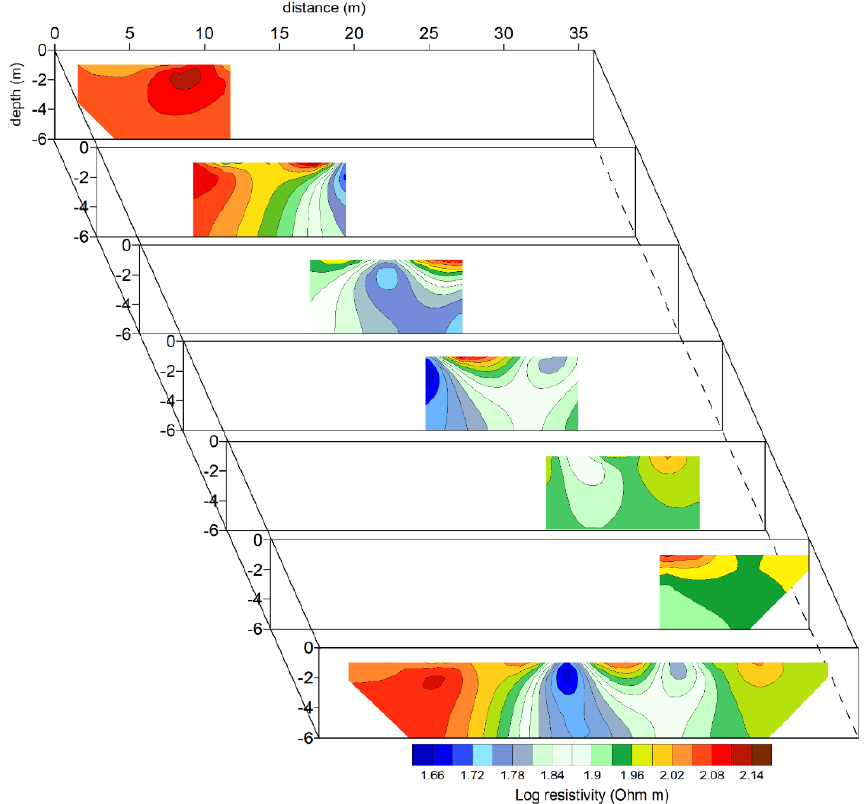
Figure 7. A perspective view of the same synthetic experiment as in Figure 6, but with PERTI sections displayed every 5 m along the profile axis, and estimation of ρ m with linear best-fit procedure (frontmost section).